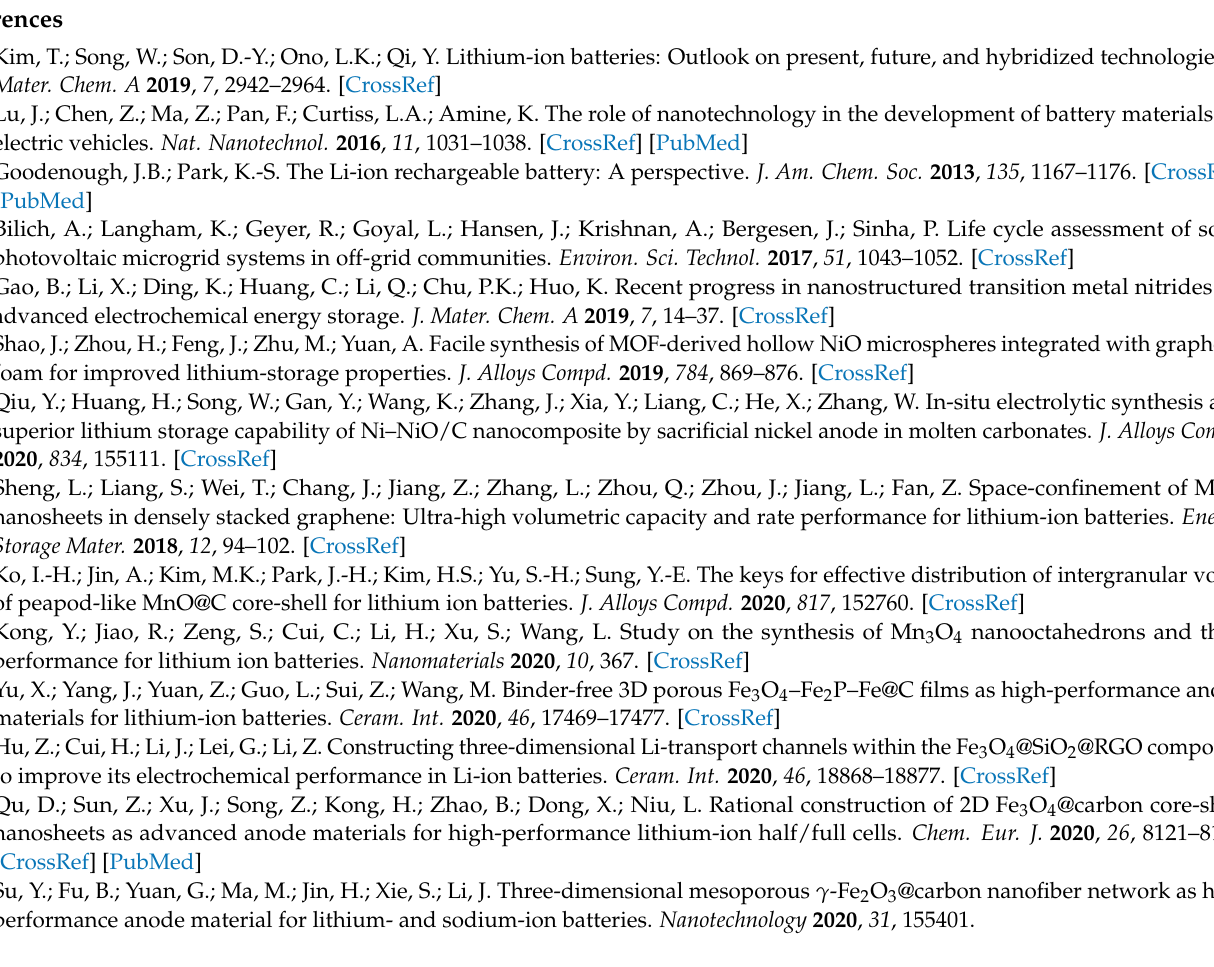
Figure S2: EDS microanalysis reports of the nanotubular Na 2 MoO 4 /TiO 2 composites with different Na 2 MoO 4 contents: (a) Na 2 MoO 4 –15.4%-TiO 2 , (b) Na 2 MoO 4 –24.1%-TiO 2 , (c) Na 2 MoO 4 –41.4%-TiO 2 . Figure S3: XRD pattern of the pure Na 2 MoO 4 powder. Figure S4: SEM images of (a) the pure Na 2 MoO 4 powder and (b) the pure TiO 2 nanotubes samples. Figure S5: TEM images of (a) the pure Na 2 MoO 4 powder and (b) the TiO 2 nanotubes samples. Figure S6: The Cyclic voltammetry curves of the pure Na 2 MoO 4 anodic material measured at a scan rate of 0.1 mV s − 1 over the potential window of 0.01–3.0 V vs. Li + /Li. Figure S7: The discharge–charge voltage profiles of the (a) pure TiO 2 nanotubes, (b) pure Na 2 MoO 4 powder, (c) Na 2 MoO 4 –15.4%-TiO 2 nanocomposite and (d) Na 2 MoO 4 –24.1%-TiO 2 nanocomposite at the 1st, 2nd, 10th, 20th, and 50th cycles under a constant current density of 100 mA g − 1 between 0.01 and 3.0 V vs. Li +